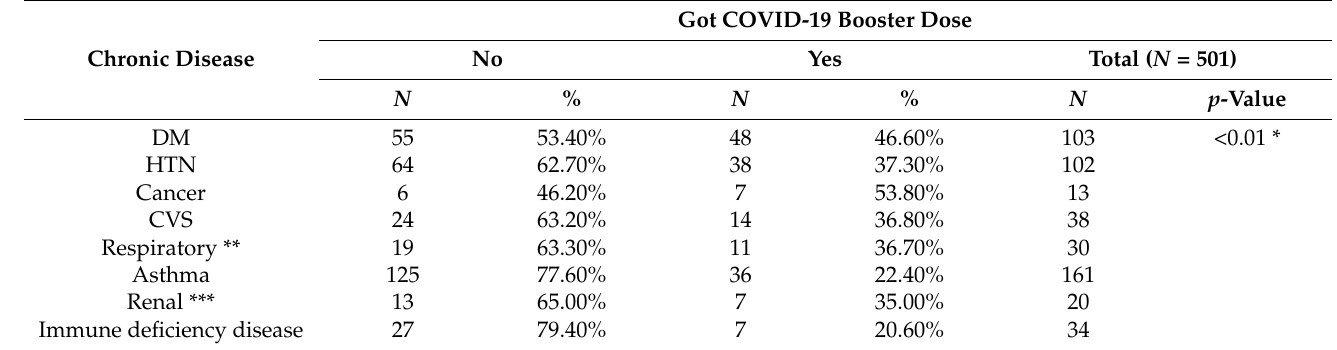
Table 4. Association of COVID-19 Booster Dose Uptake with Participants Who Have Chronic Diseases.